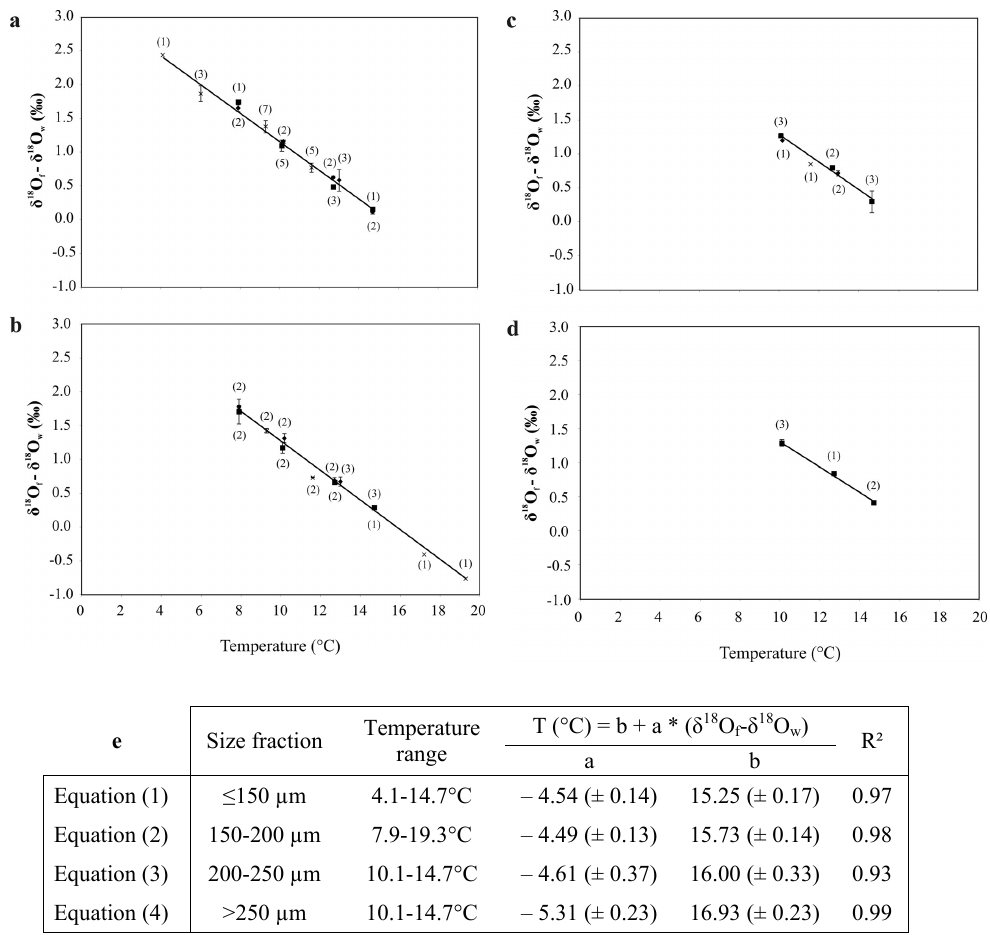
Fig. 1. Experimental calibration equations of temperature versus δ 18 O f − δ 18 O w of cultured specimens of B. marginata . Averages and standard deviations are presented separately for the ≤ 150µm (a) , 150–200µm (b) , 200–250µm (c) , and > 250µm (d) shell size fractions. The number of measurements for each average value is indicated in parenthesis. Different symbols correspond to the three systems: PD (diamonds), CS I (squares) and CS II (crosses). The calibration equations summarised in (e) are based on all data from each size fractions (for all equations p < 0 . 001 )